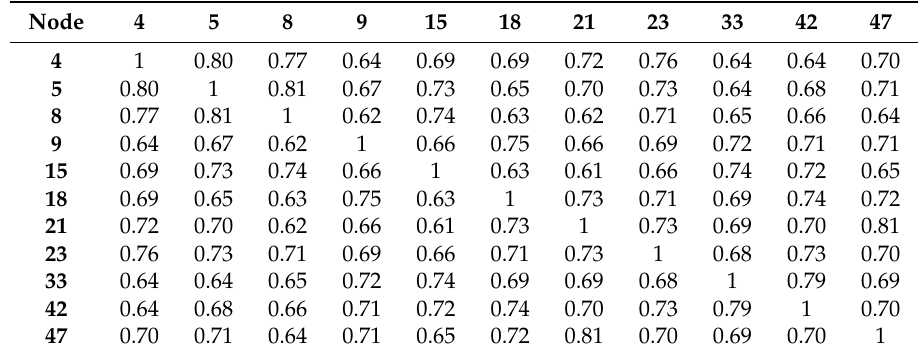
Table 2. Entropy correlation coefficient of each pair from the dataset 1.